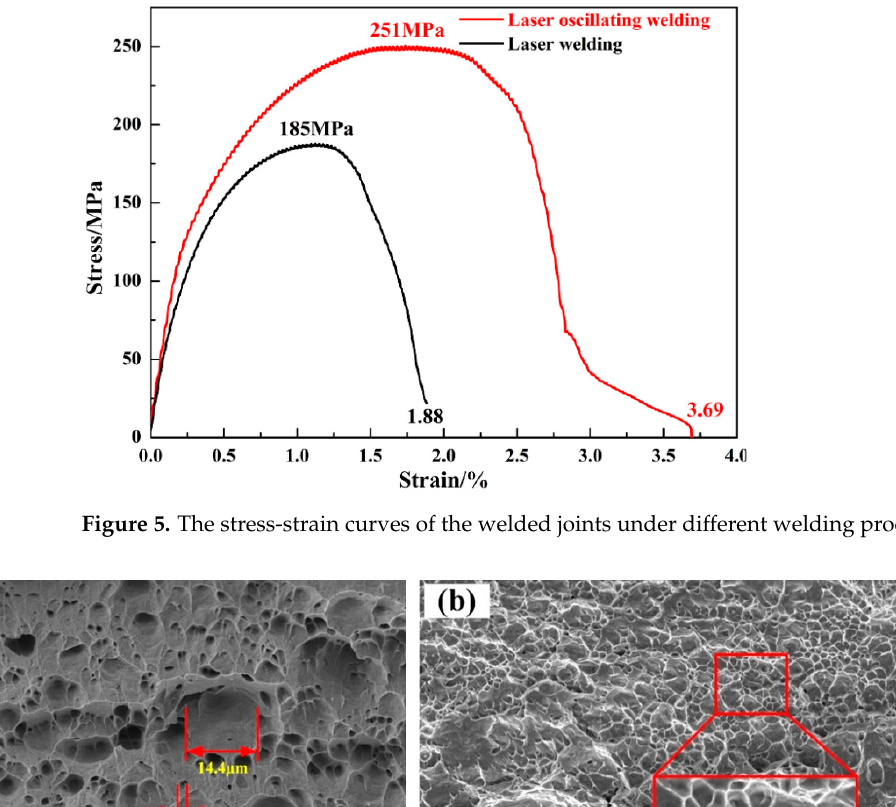
Figure 5. The stress-strain curves of the welded joints under different welding processes.